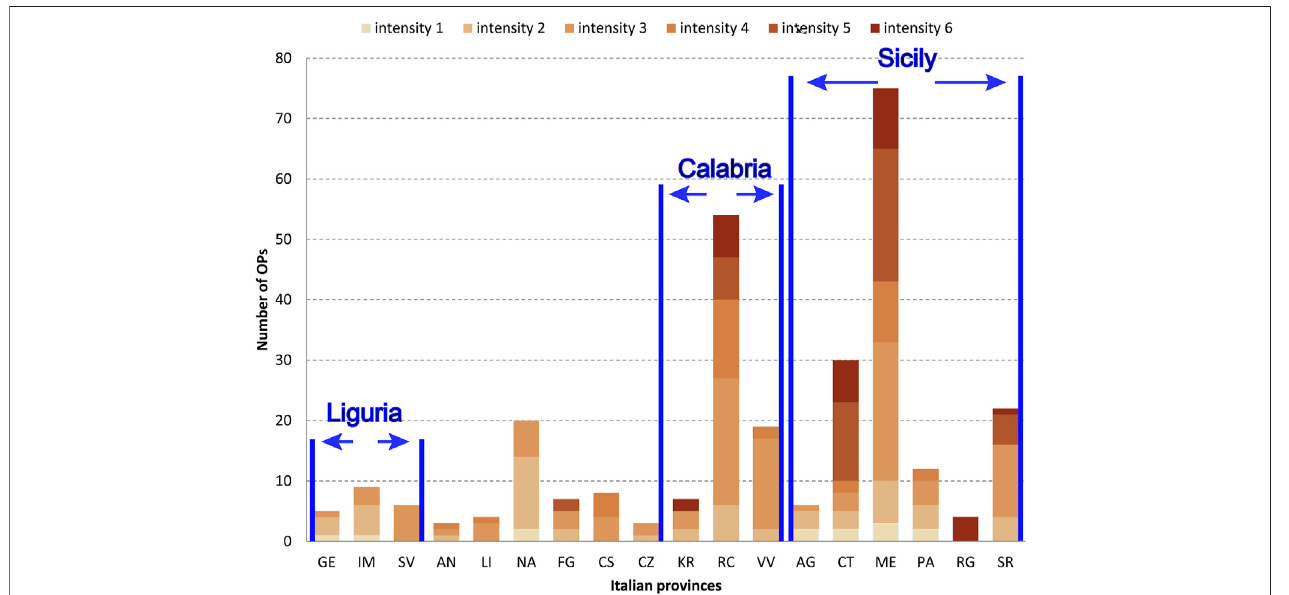
FIGURE 8 | Distribution of local intensities per Italian provinces with at least three Observation Points (OPs).